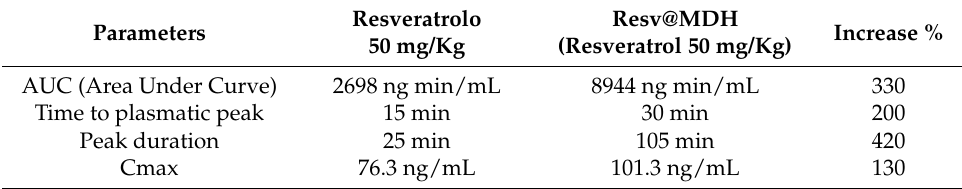
Figure 5. Pharmacokinetic profiles of resveratrol after oral administration in rabbits. Groups of 4 animals each were treated with resveratrol (50 mg/Kg of pure resveratrol versus Resv@MDH). Blood samples taken at 0, 5, 15, 30, 45, 90, 120 and 180 min. Table 2. Pharmacokinetic parameters of oral administration of 50 mg/Kg of resveratrol from pure resveratrol and from Resv@MDH.